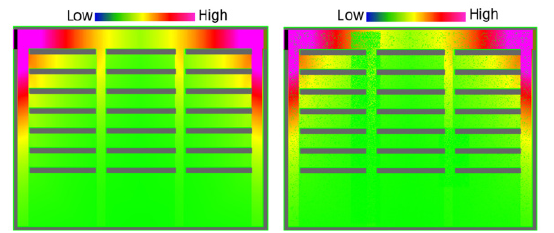
Fig. 23 Total attractive value map in the dynamic method. Left: initial total attractive value map. Right: total attractive value map for higher R (for easy visualization). In regions occupied by agents, total attractive values are lower.